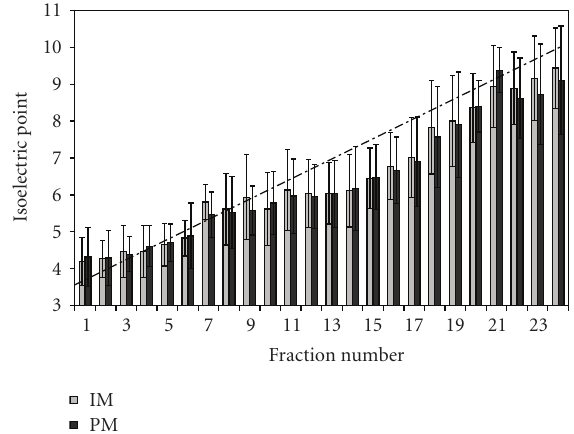
Figure 3: Analysis of the quality of the OFFGEL fractionation of iTRAQ-labelled peptides from immunoa ffi nity depleted (IM) or hexapeptide ligand library treated (PM) plasma. The average experimental pI of all peptides in each of the 24 OFFGEL fractions after filtering for false positive is presented as bars. Error bars indicate the SD of each fraction’s experimental pI. The broken line is based on the theoretical pI values for an IPG strip of 24cm, pH 3–10 provided by Agilent